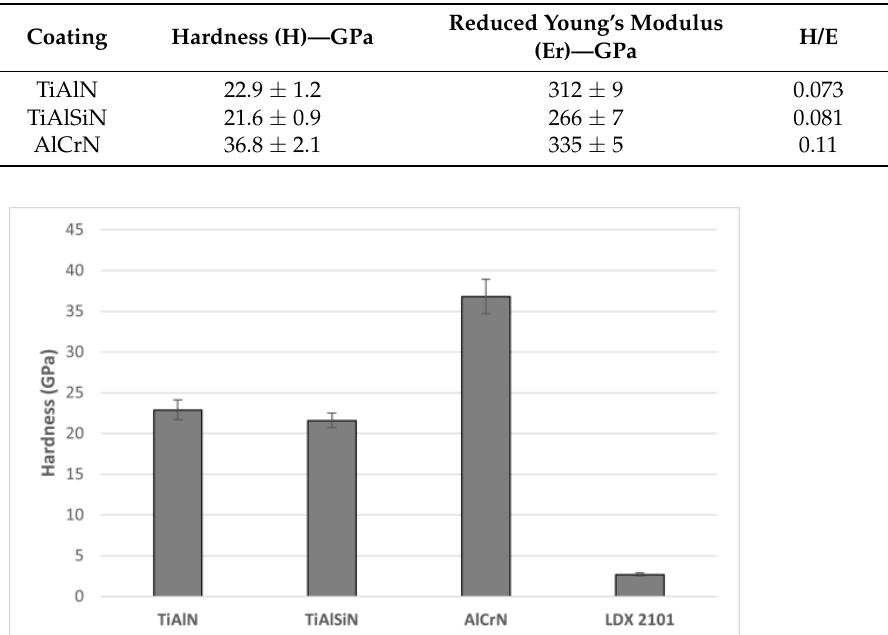
Table 6. Average hardness, Young’s modulus, H/E and H 3 /E 2 ratio values obtained for the produced coatings.